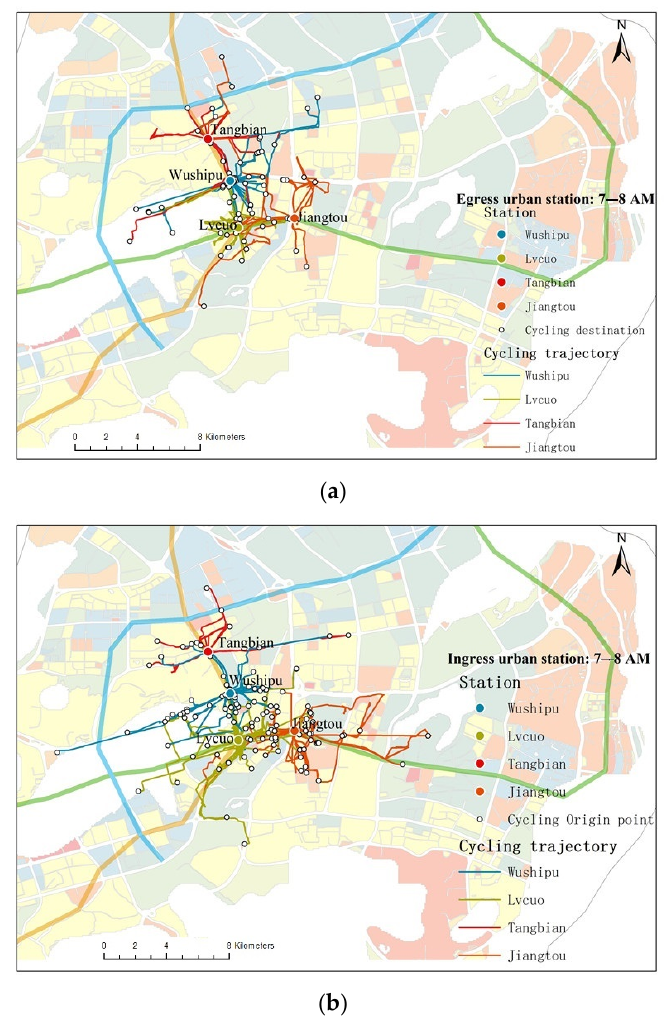
Figure 9. ( a ) Cycling trajectory for egress metro station between 7:00 and 8:00 a.m. ( b ) Cycling trajectory ingress metro station between 7:00 and 8:00 a.m.